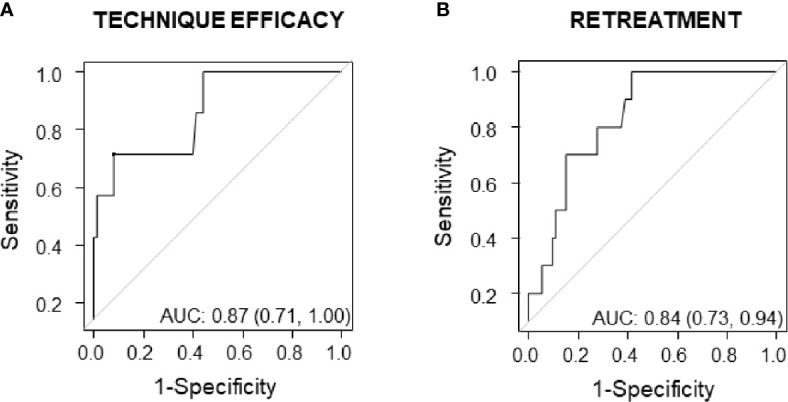
ROC curves showing predictive accuracy of IAR for technique efficacy (A) and for retreatment (B).